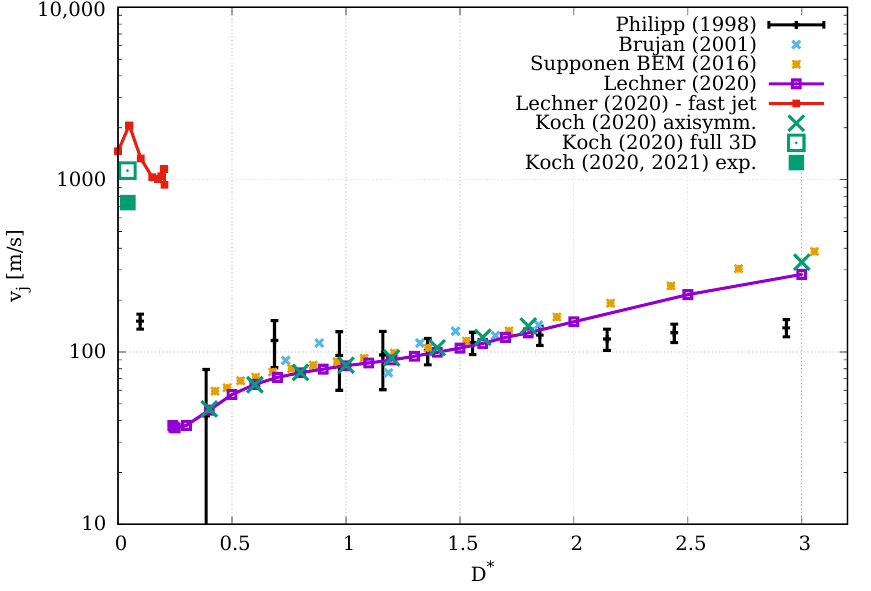
Figure 21. Jet velocities of a bubble in the vicinity of a flat solid boundary, measured and simulated by different authors: Philipp and Lauterborn [12] (measurements), Brujan et al. [96] (measurements), Supponen et al. [18] (Boundary Element simulation), Lechner et al. [53] and Koch [58] (simulations with the present code), as well as Koch [58] and Koch et al. [59] (measurement of the fast jet). The experimental data in [12,96] were obtained for laser-generated cavitation bubbles in water under normal ambient conditions ( p ∞ = 101325Pa and ρ l = 998kg/m 3 ). In the numerical work in [53,58,59], the same ambient conditions were assumed. The dimensionless values given in [18] have been incorporated into this diagram, using the values ∆ p = p ∞ − p v with p ∞ = 101,325 Pa, p v = 2337 Pa and ρ l = 998kg/m 3